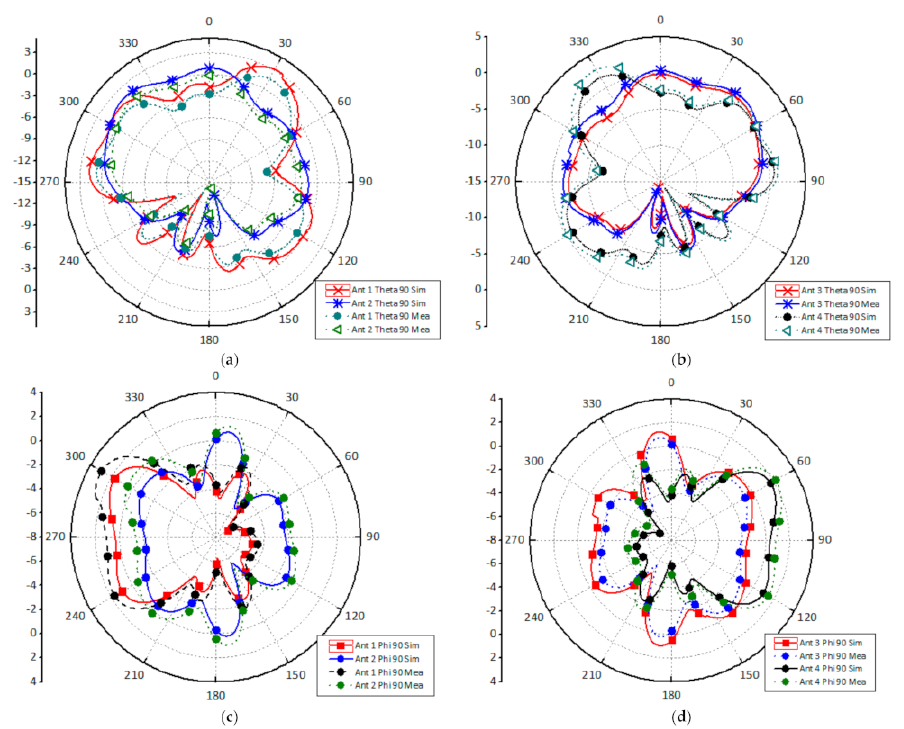
Figure 7. Radiation Patterns. ( a ) Ant 1 Ant 2 Theta 90 ( b ) Ant 3 Ant 4 Theta 90 ( c ) Ant 1 Ant 2 Phi 90 ( d ) Ant 3 Ant 4 Phi 90.